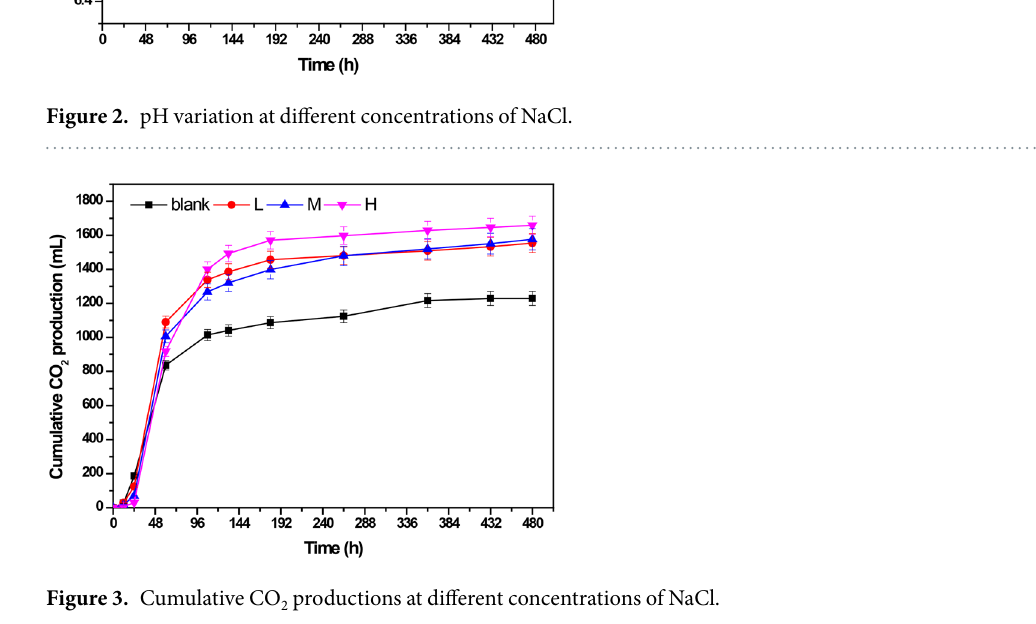
Figure 3. Cumulative CO 2 productions at different concentrations of